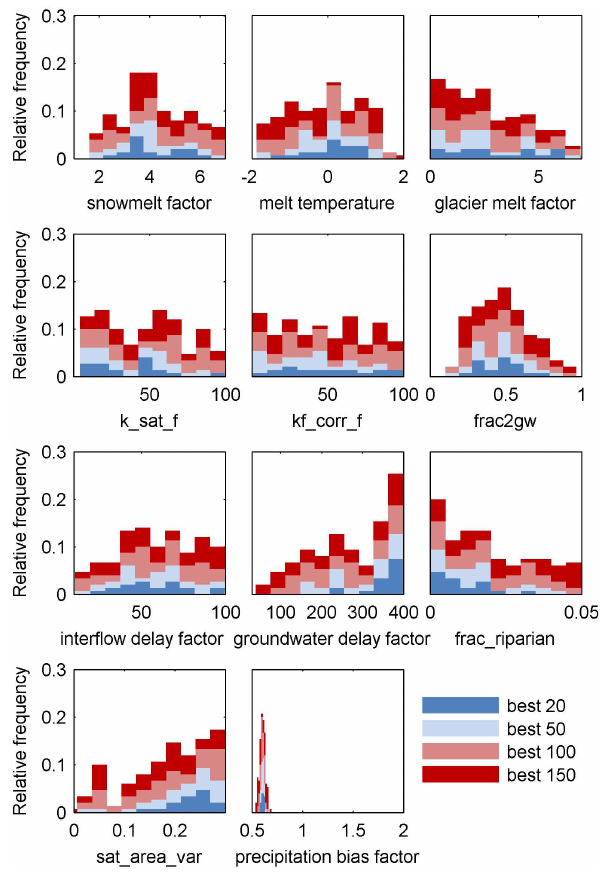
Fig. 8. Histograms of the parameter distributions for the best 20, 50, 100 and 150 parameter sets for the subcatchment Gulcha, precipita- tion estimate “WRF” and time period